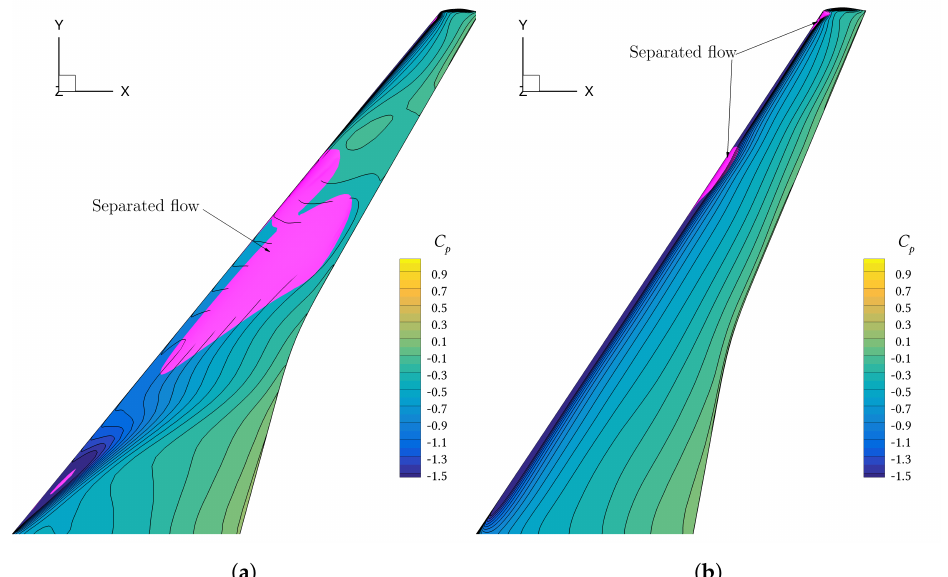
Figure 16. Separation on the upper surface at 9 degrees angle of attack is nearly eliminated with the low-speed separation constraint. ( a ) Single-point. ( b ) Single-point with low-speed separation